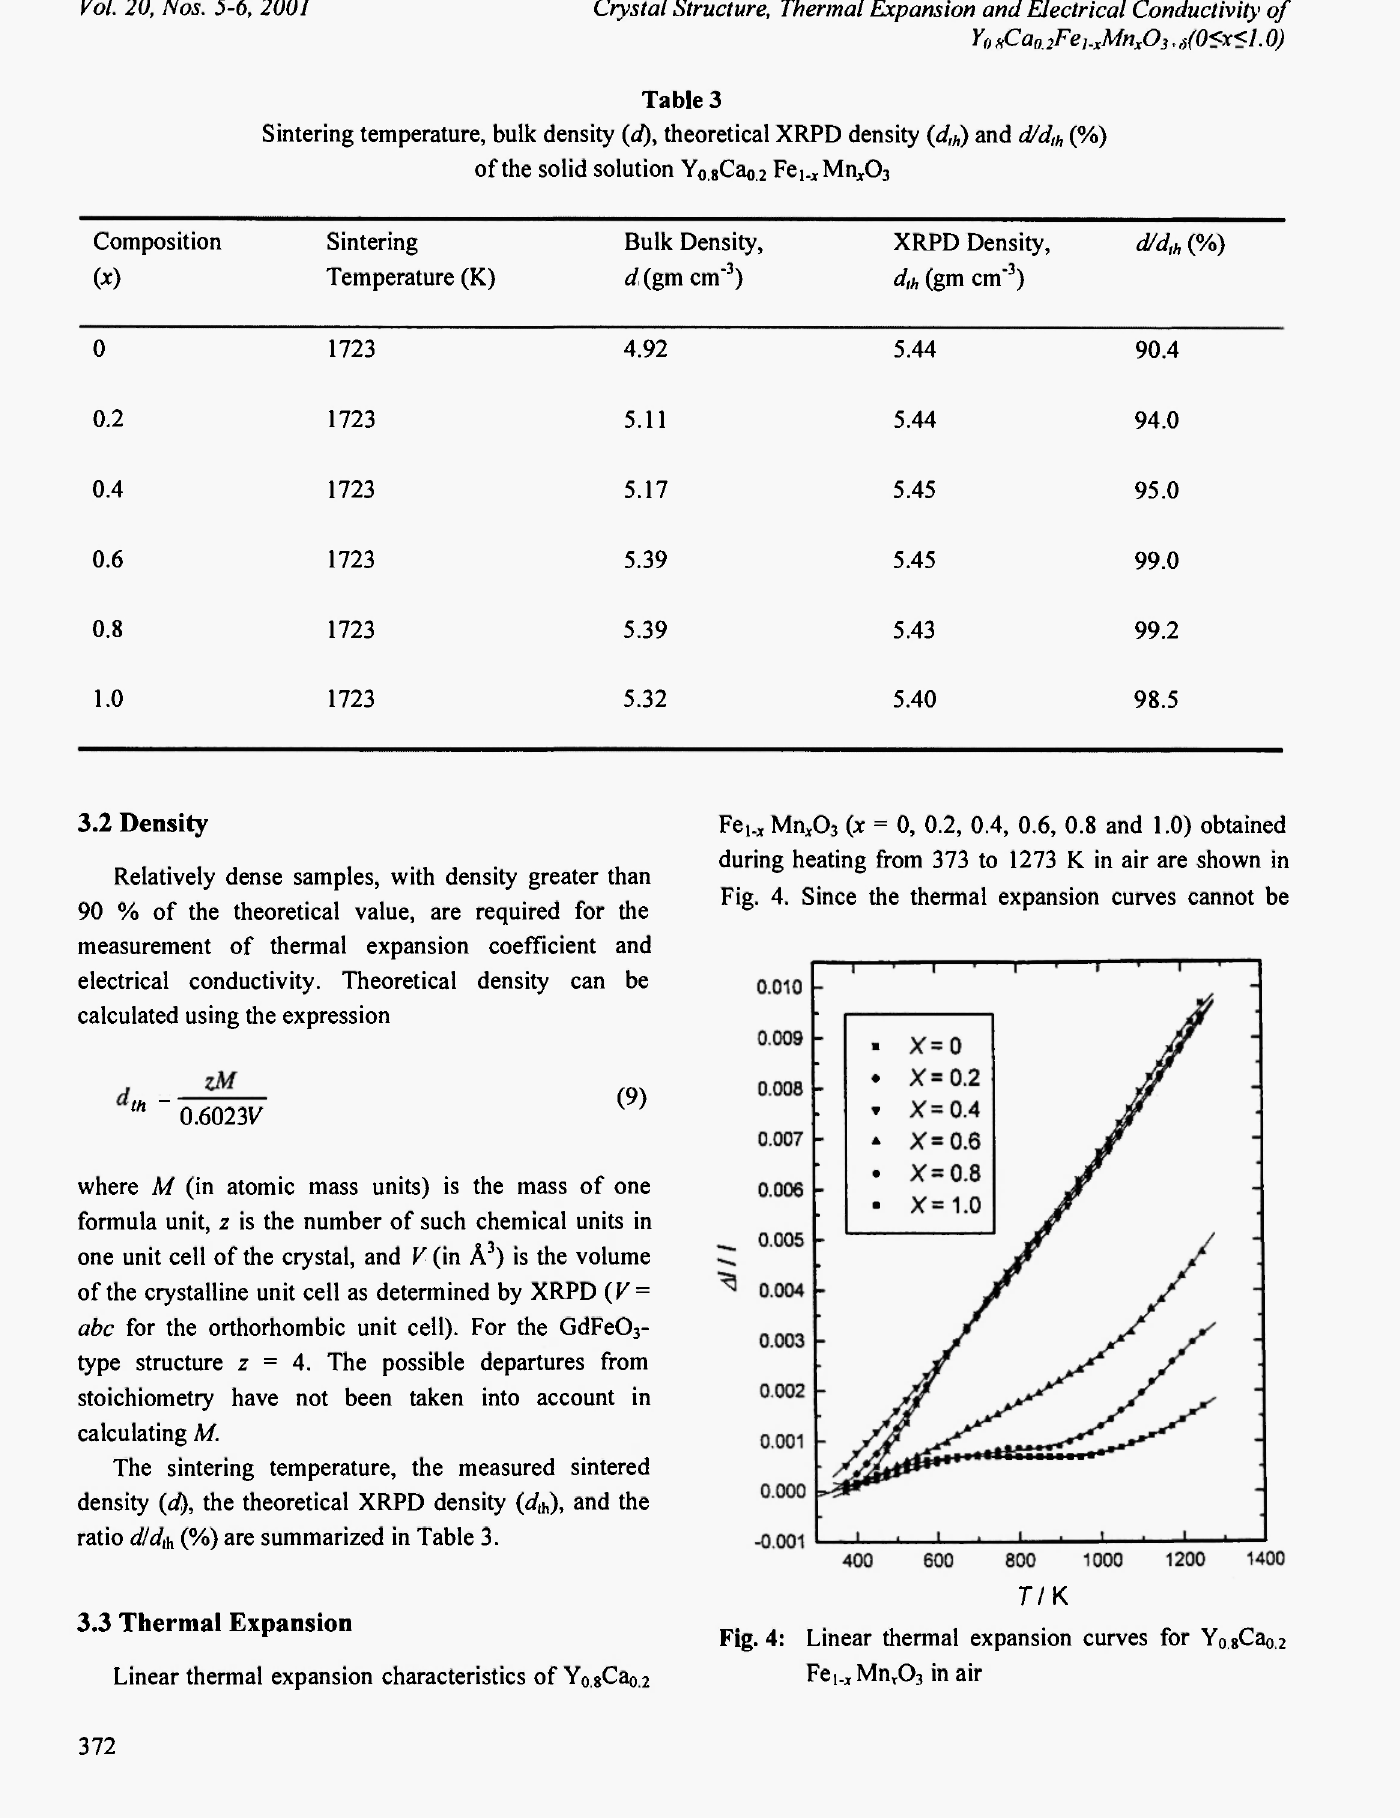
Sintering temperature, bulk density ( d ), theoretical XRPD density (d, h ) and d/d, h (%) of the solid solution Yo.sCao.2 Fei_ x Mn jr 0 3